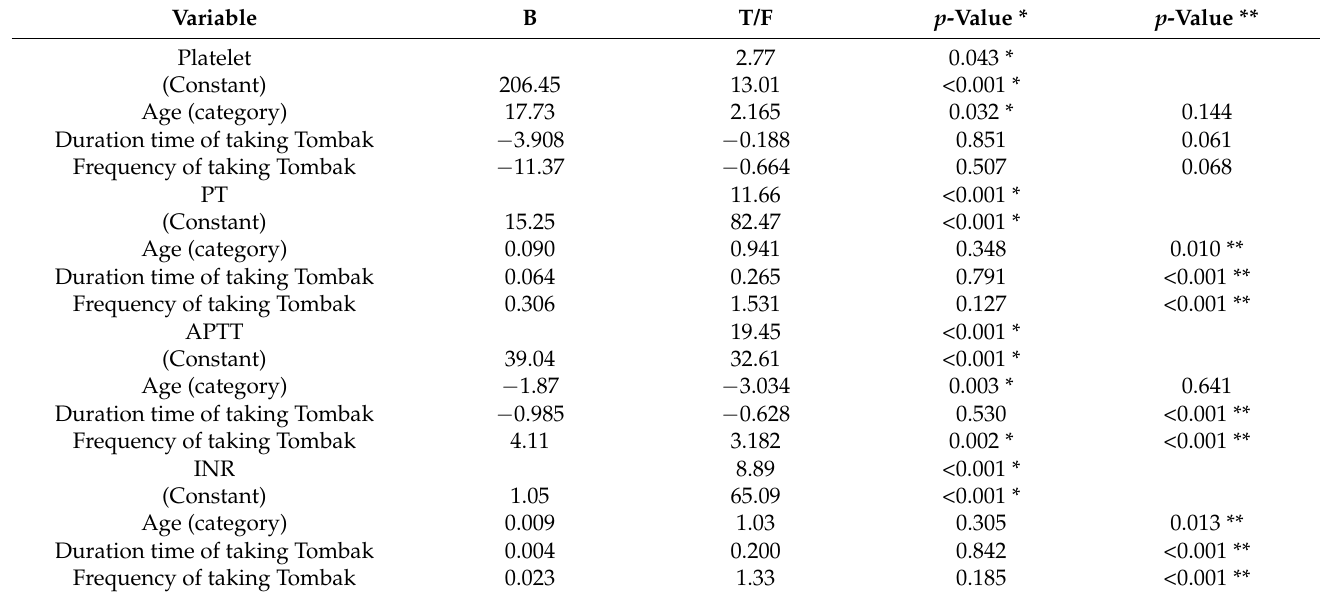
Table 5. The effects of taking oral Tombak on PT, APTT, INR, and PLT values among the study